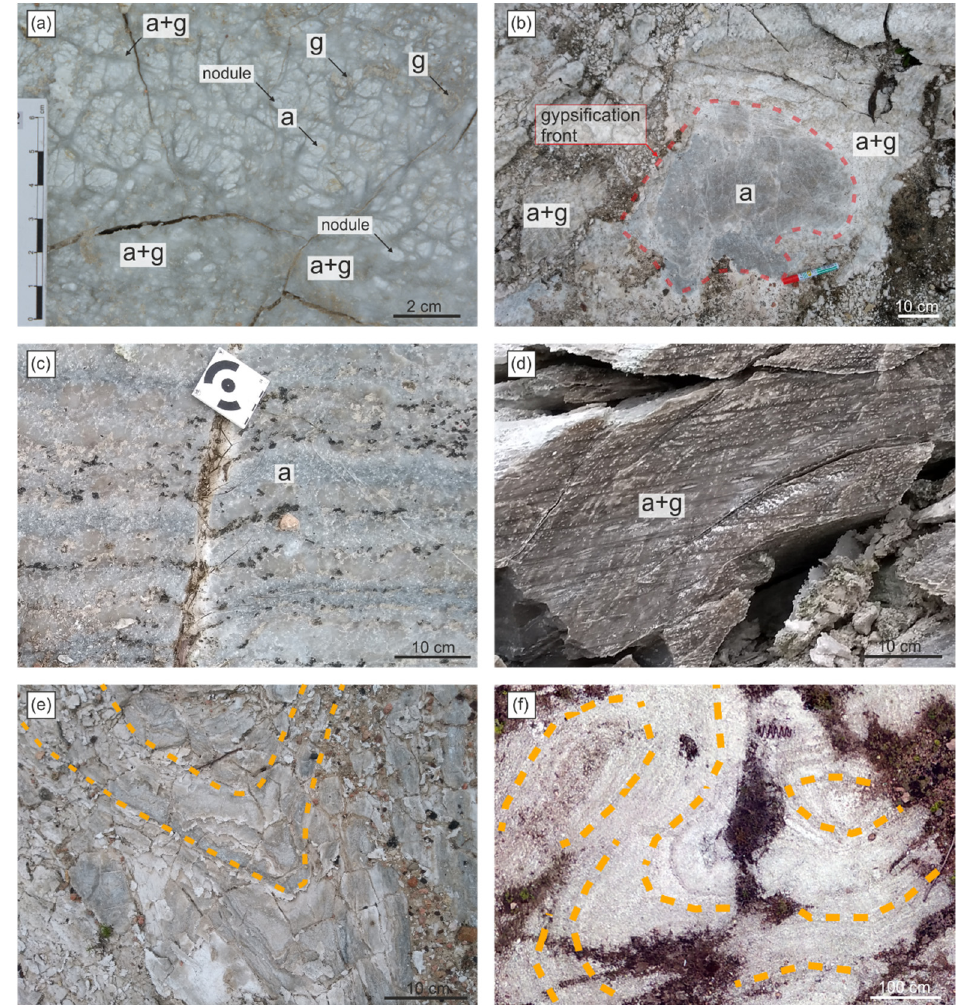
Figure 4. Macroscopic view of gypsum anhydrite rocks showing characteristic structures (g– gypsum, a–anhydrite): ( a )–fractured layer composed of white anhydrite nodules and grey gypsum wisps (upper part of the photo) passing into grey fractured gypsum-dominated rock (lower part of the photo); ( b )–macroscopic gypsification front around the relict anhydrite meganodule; ( c )–layered anhydrite-dominated rock cut by fault and disturbed by drag fold; ( d )–flat layered gypsum-anhydrite rock; ( e , f )–folded layers of gypsum-anhydrite rock seen at the bottom of the quarry.